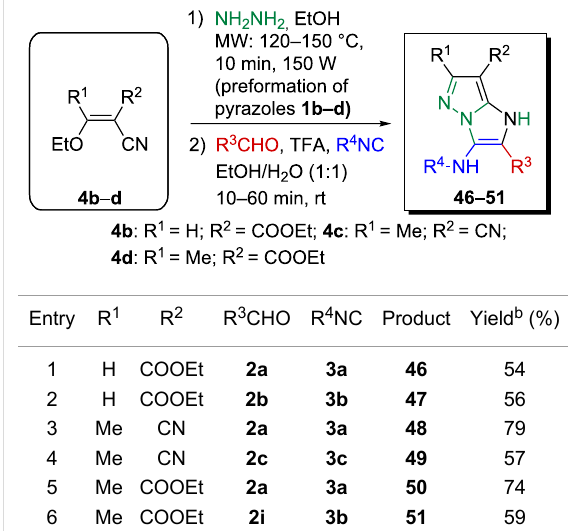
Table 3: Synthesis of highly substituted 1 H -imidazo[1,2- b ]pyrazoles a